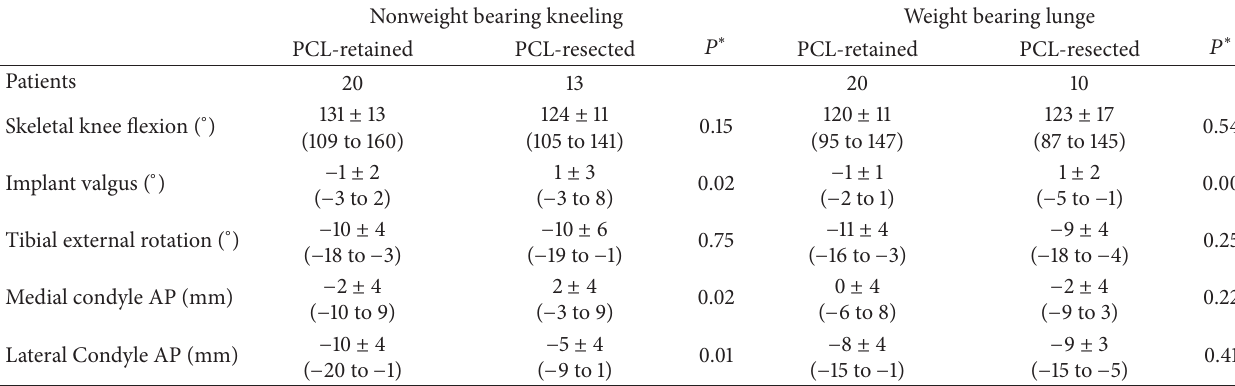
Table 2: Kinematics during the kneeling and lunge activities for the PCL-retained and PCL-resected groups (mean ± standard deviation,